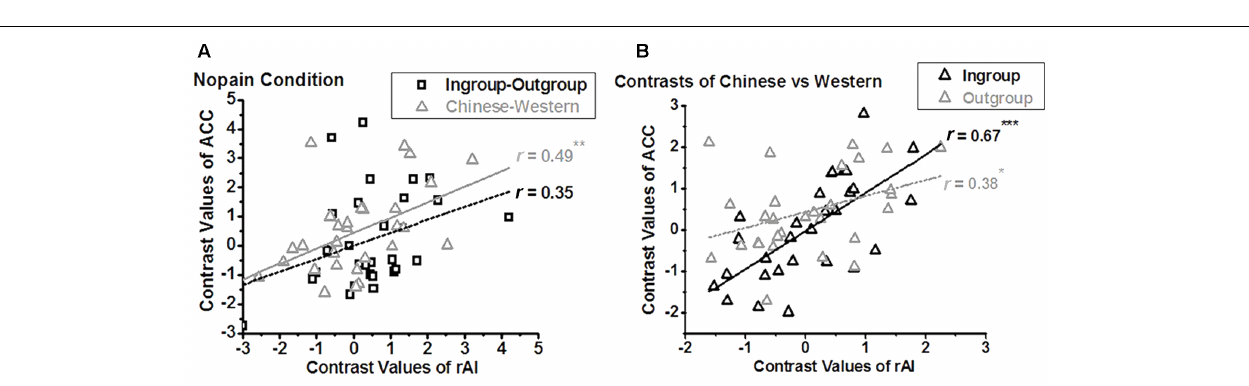
FIGURE 4 | Correlation between D-index and the contrasts of Chinese vs. Western of the ACC. (A) a significant negative correlation was found in the nopain condition (indexed by gray), but (B) a significant positive correlation was found in the pain condition (indexed by black), ∗ adjusted p < 0.05.